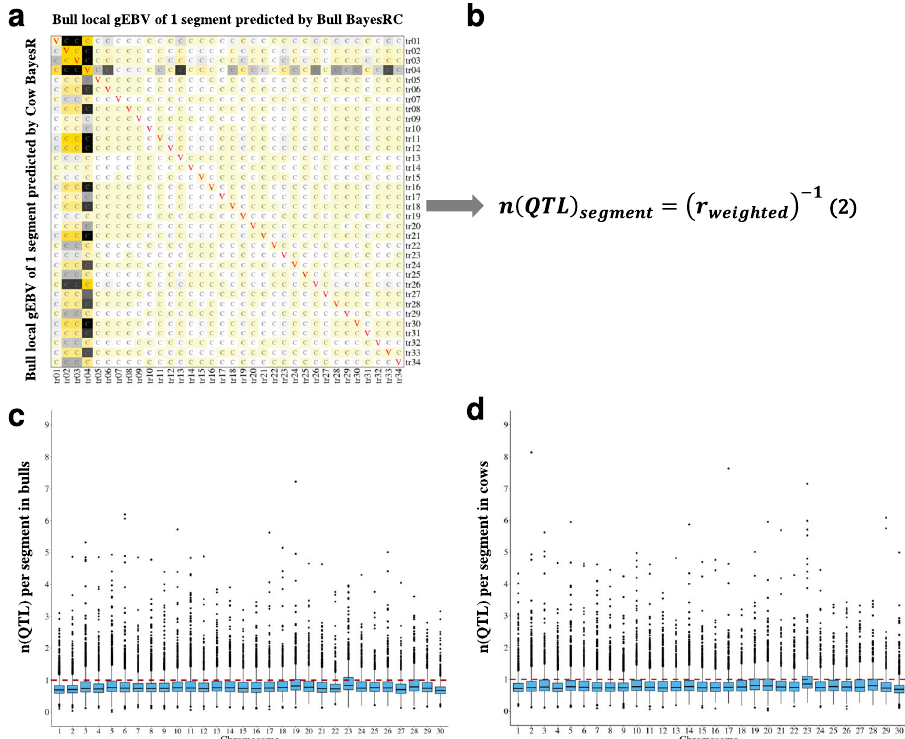
Fig. 3 The estimation of the indictive number of pleiotropic QTL across 34 traits (tr01 – tr34) for each chromosome segments. a An asymmetric matrix of the variance and covariance of local gEBV of 34 traits for a chromosome segment. The asymmetry (the colour difference between elements above and below the diagonal) of the matrix is due to the use of two sets of local gEBV to calculate the covariance from different training populations (bulls or cows). The yellow colour indicates positive values and the dark colour indicates negative values. The diagonal elements are labelled as red ‘ V ’ (variance) and the off-diagonal elements are labelled as grey ‘ C ’ (covariance). b Equation (2) uses the inverse of the weighted correlation ( r weighted ) of the asymmetric variance and covariance matrix (panel a ) to estimate the number of QTL within each segment ( n ( QTL ) segment ). c boxplot for the estimation of the number of QTL across 39,635 chromosome segments in bull data. d Boxplot for the estimation of the number of pleiotropic QTL across 40,763 chromosome segments in cow data. Each dot on c and d indicate the estimated number of causal QTL per segment. For each box, the minimum is the lowest point, the maximum is the highest point, whiskers are maxima 1.5 times of interquartile range, the bottom bound, middle line and top bound of the box are the 25th percentile, median and the 75th percentile,